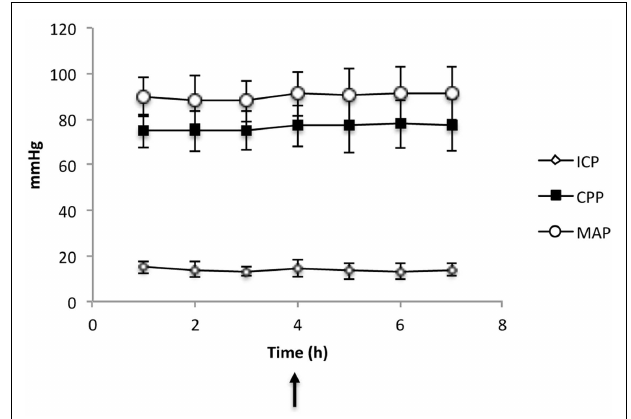
FIGURE 2 | Physiological parameters (CPP, cerebral perfusion pressure; MAP, mean arterial pressure) and ICP (Intracranial pressure) in all nine patients before and after Xenon-CT (indicated by the arrow) .The values are given as mean ± SD.